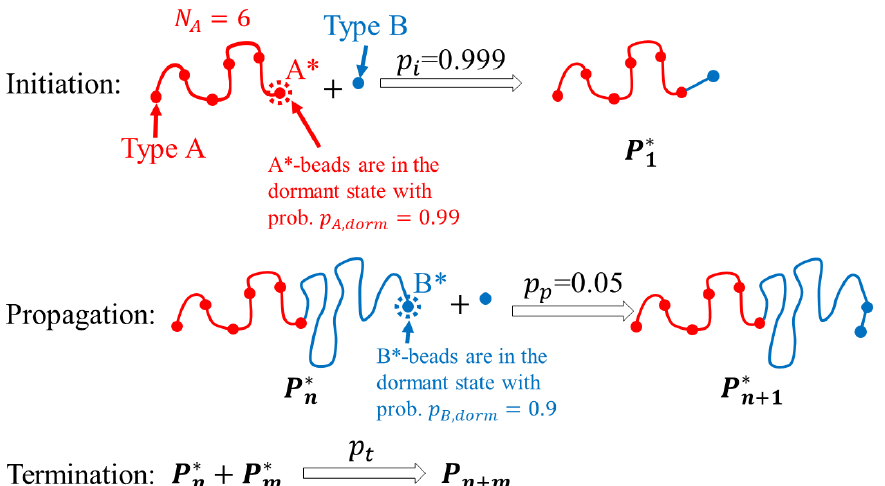
Figure 1. Algorithm of the ATRP simulation.